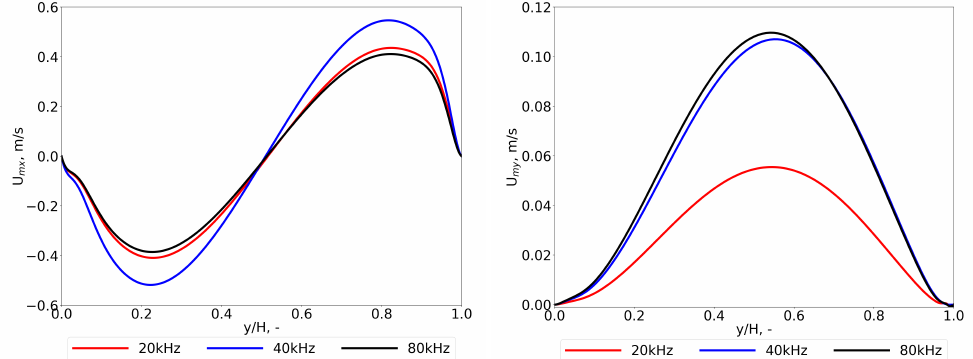
Figure 9. ( Left ): comparison of x component of streaming velocity u mx for cases 1C*, 2C, and 3C along vertical line for x = 0.75 L, 0 < y < H ; ( Right ): comparison of y component of streaming velocity u my for cases 1C*, 2C, and 3C along vertical line for x = 0.5 L, 0 < y <